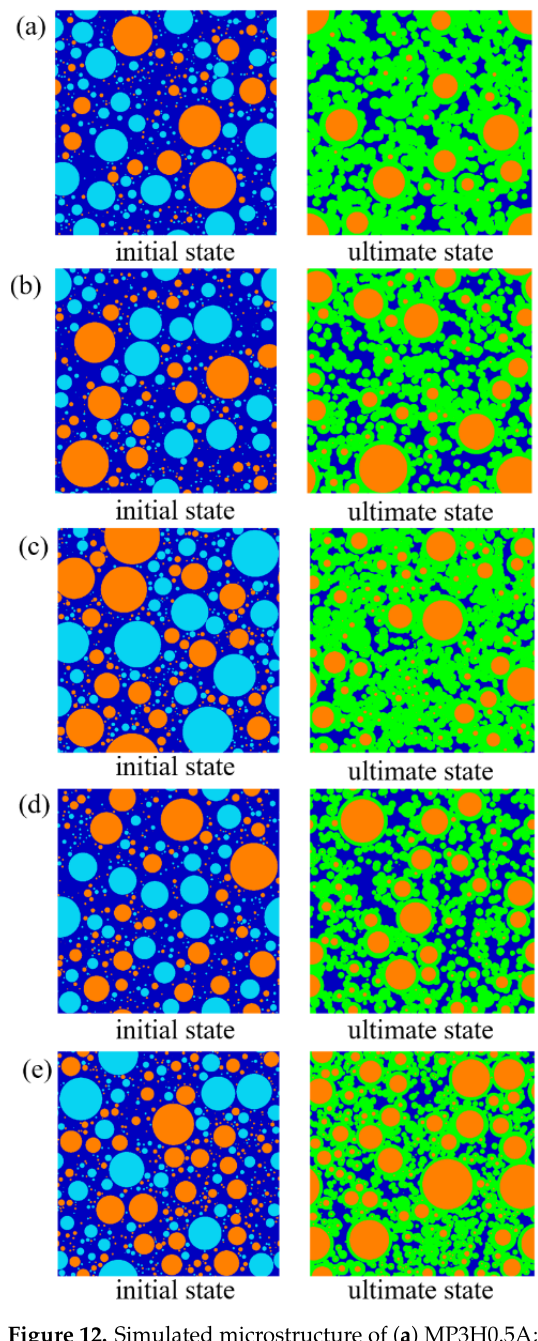
Figure 12. Simulated microstructure of ( a ) MP3H0.5A; ( b ) MP4H0.5A; ( c ) MP5H0.3A; ( d ) MP5H0.5A; and ( e ) MP8H0.3A.